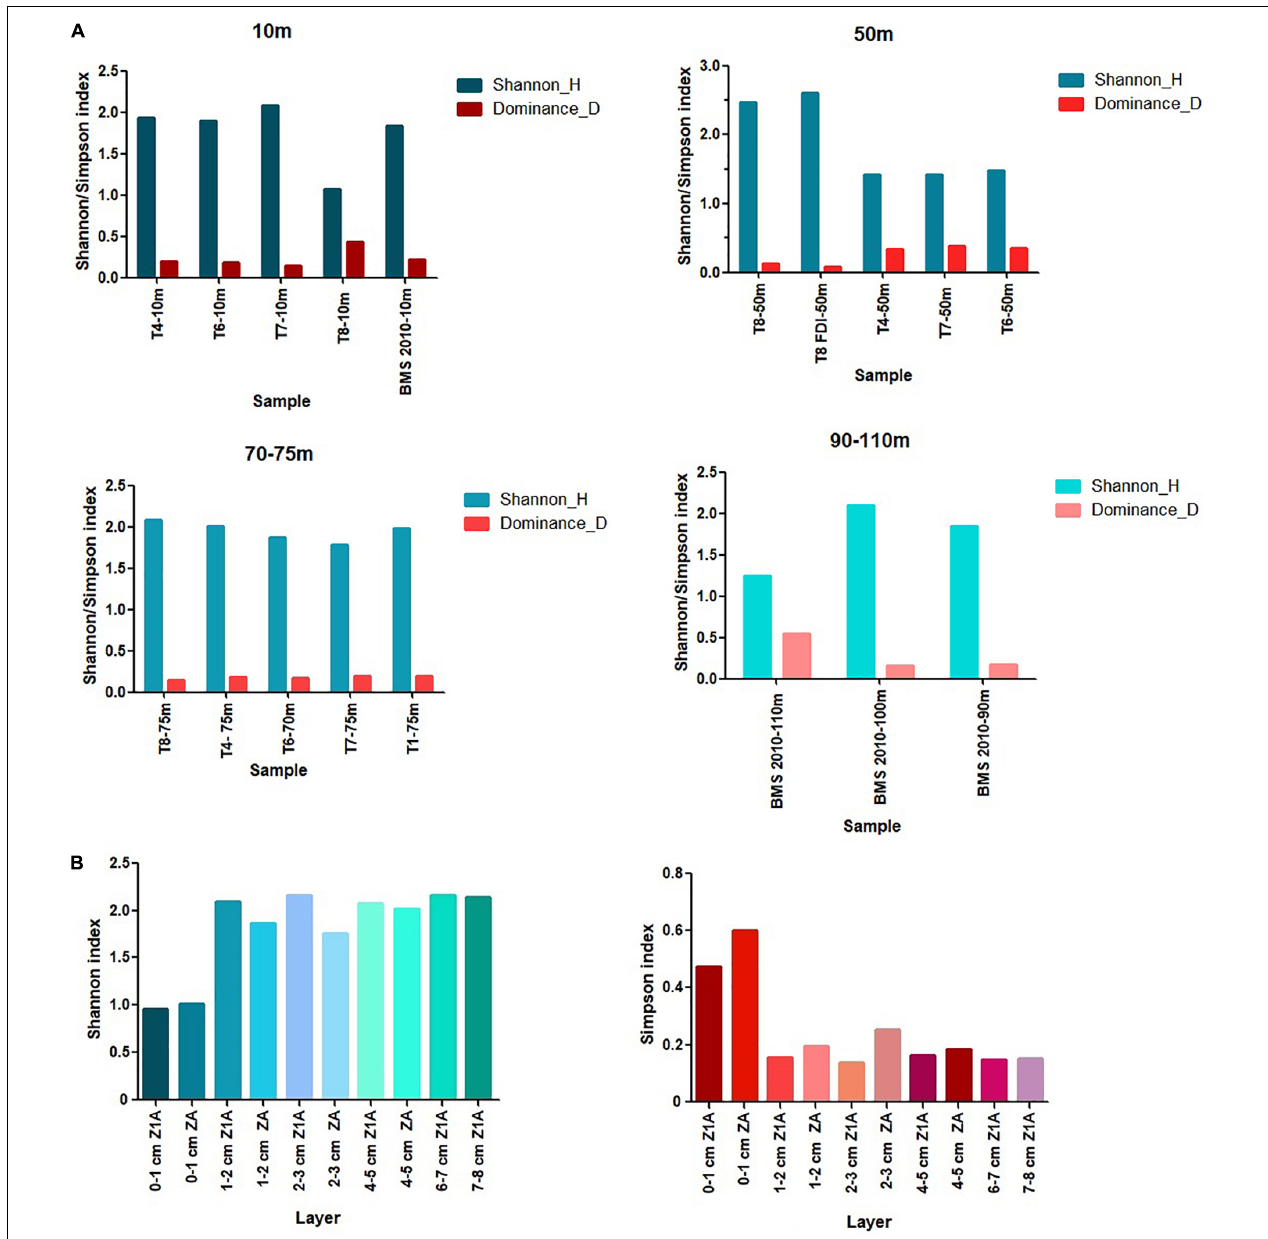
FIGURE 8 | Values of the Shannon (H (cid:48) ) and Simpson (D) diversity indices on the spatial (A) and vertical distribution (B)